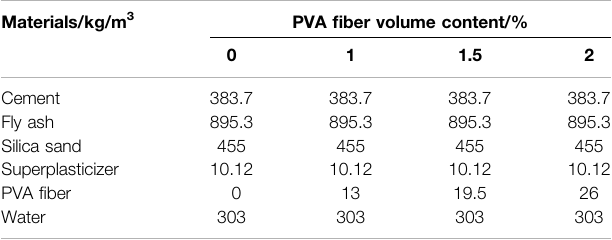
TABLE 1 | Mixture proportions for ECC matrix with different fi ber volume